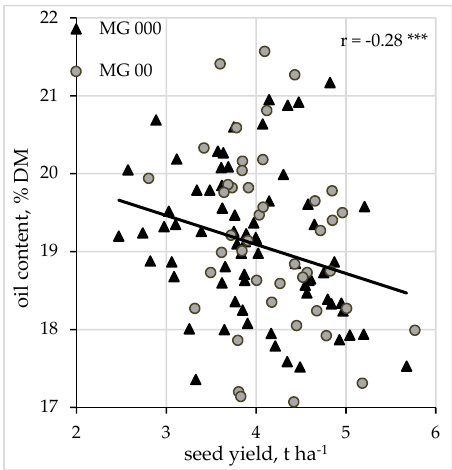
Figure 2. Correlation between seed yield and oil content of soybean. Figure shows results from 13 varieties from the maturity groups MG 00 and MG 000 at five locations and two trial years (2016, 2017). *** p < 0.001.